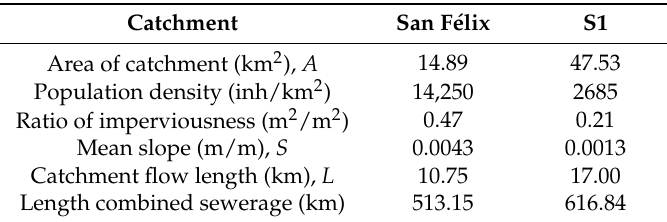
Figure 1. Location of the study site. Table 2. Catchments